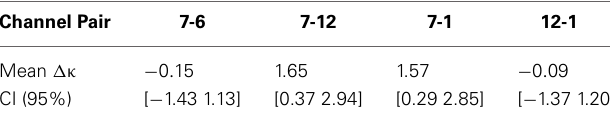
Table 1 | Pairwise comparison between selected ROIs inside and outside language network (Tukey’s test).